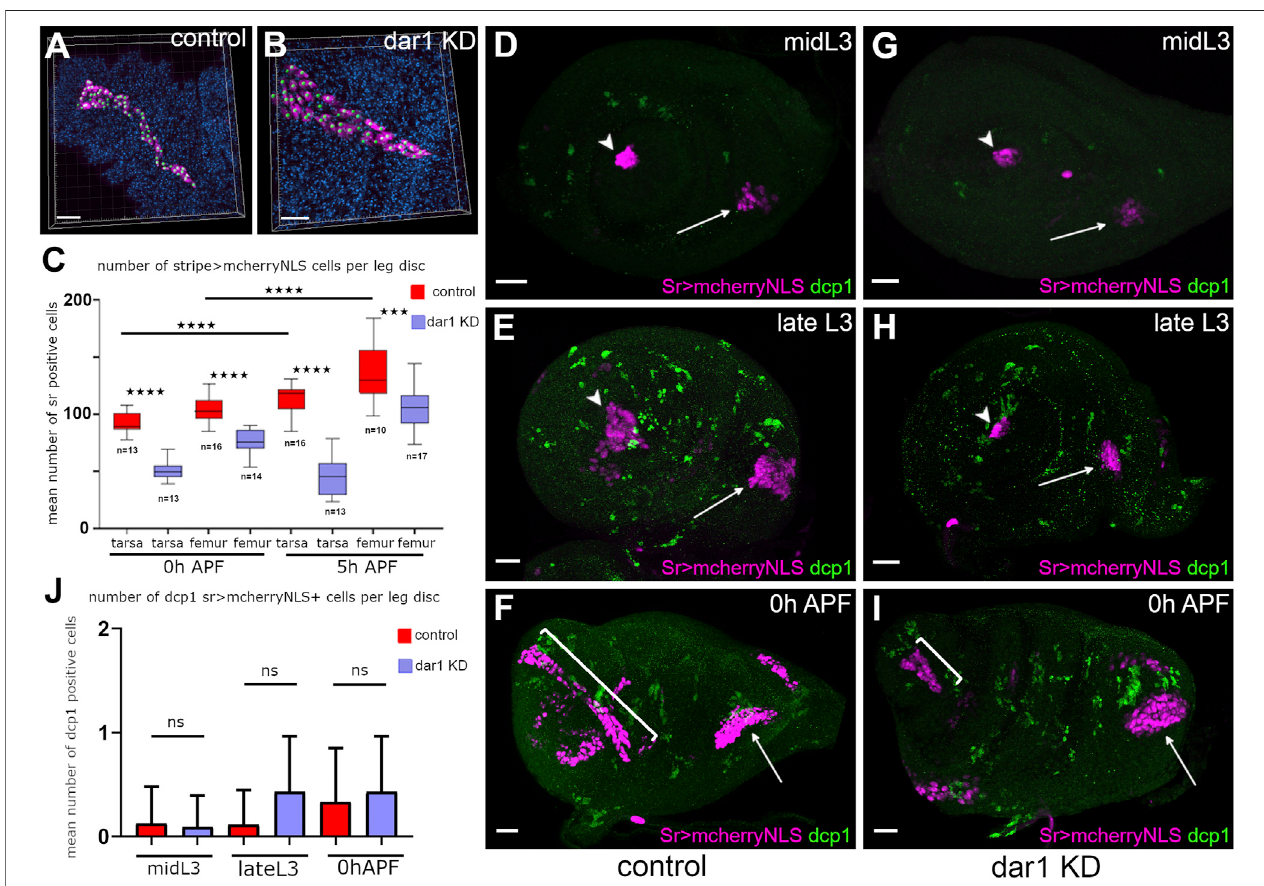
FIGURE 6 | Reduction of tendon cell number in dar1 KD leg discs is not due to ectopic apoptosis (A,B) examples of semi-automated counting tendon cells (magenta)fromZ-stackprojectionsofconfocalimagesofltfromsr-gal4,dar1 3010/+ > UAS-mcherryNLS(A)andsr-gal4,dar1 3010/+ > UAS-mcherryNLS,UAS-dar1RNAi (B) 5 hAPFlegdiscs,stainedwithDAPI(blue).Eachgreenspotcorrespondstoasinglecell (C) Box-plotdiagramcomparingnumberofmcherry-positivecellsinltandinthe tilt, incontroland in dar1 KDlegdiscsat twodifferenttime points. Boxboundariesand horizontalbarindicate 25/75percentileand meanvalue,respectively. *** p < 0.001 and **** p < 0.0001 (Bonferroni or Welch test) (D – I) Confocal images of sr-gal4,dar1 3010/+ > UAS-mcherryNLS (magenta) (D – F) and sr-gal4,dar1 3010/+ > UAS- mcherryNLS,UAS-dar1RNAi (G – I) leg discs immunostained with anti-dcp1 (green) at different times of development. Arrowheads and arrows point to tarsal lt and tilt in femur,respectively.In both control (D) and dar1 KD (G) L3 leg discs,cell death cannotbe detected inltortilt. Atlate L3, severalapoptotic cells areobserved throughout the leg discs (E,H) but none of them are tendon cells. As stated previously, at this time there are already fewer tendon cells in the dar1 KD leg disc (H) than in the control (E) . At early metamorphosis, lt (bracket) appears much shorter in the dar1 KD leg disc (I) than in the control (F) , but no speci fi c cell death is observed in this tendon (J) Graphs showing the mean number of sr > mcherryNLS cells that are dcp1positive per disc at different stages of development in control and dar1 KD leg discs (total number of analysed discs, control n (cid:2) 23, dar1 KD n (cid:2) 25). Scale bar 20 μ m.